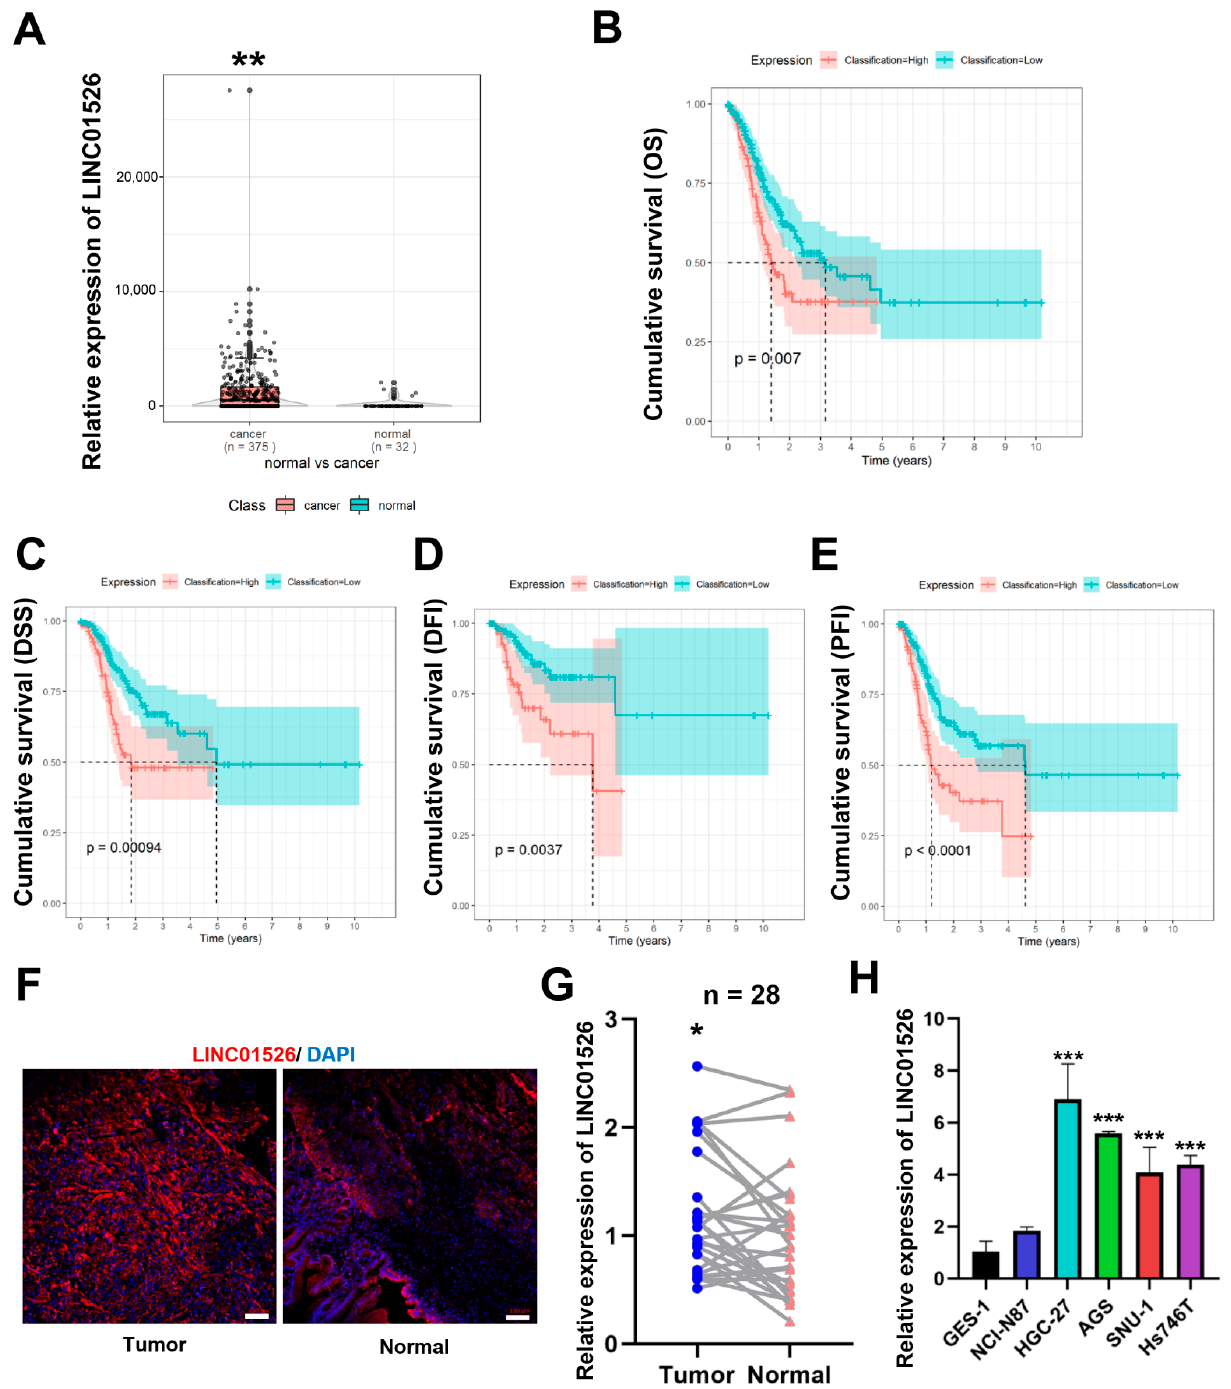
Figure 1. Relative LINC01526 expression in GC tissues and cell lines and its clinical significance. ( A ) Relative expression of LINC01526 in GC tissues (n = 375) and normal tissues (n = 32) based on TCGA datasets. ( B – E ) Kaplan–Meier curves for overall survival (OS), disease-free survival (DFS), disease-free interval (DFI), and progression-free interval (PFI) in GC patients. ( F ) The expression of LINC01526 (red) in gastric tissues and paired non-tumor tissues (n = 28) assessed by Fluorescence in Situ Hybridization (FISH) assay; nuclei were stained with DAPI (blue); scale bars: 100 µ m. ( G ) Quantification of fluorescence intensity. ( H ) LINC01526 expression in human GC cell lines (NCI- N87, HGC-27, AGS, SNU-1, and Hs746T) and the normal human gastric epithelial cell line (GES-1) assessed by RT-qPCR; n = 3 in each group. * p < 0.05, ** p < 0.01, and *** p <